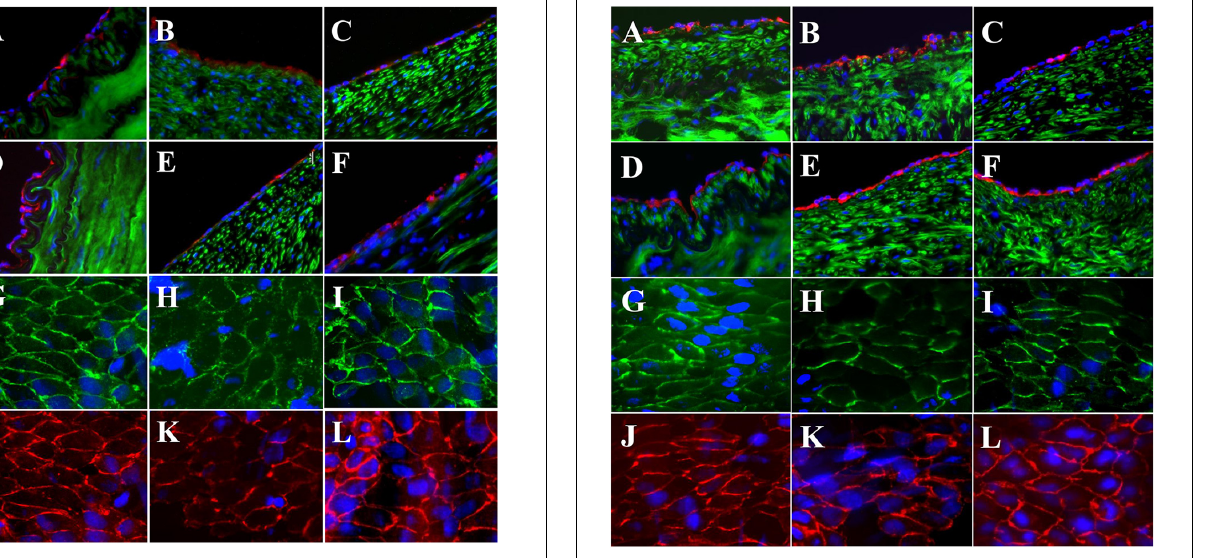
FIGURE 4 | Expression of endothelial biomarkers in neo-endothelial cells of femoral patch-angioplasty in 2-M and 4-M Groups. (A–F) Transverse. (A) Factor VIII in native artery. (B) Factor VIII in 2-M Group. (C) Factor VIII in 4-M Group. (D) eNOS in native artery. (E) eNOS in 2-M Group. (F) eNOS in 4-M Group. (G–L) En face. (G) VE cadherin in native artery. (H) VE cadherin in 2-M Group. (I) VE cadherin in 4-M Group. (J) PECAM-1 in native artery. (K) PECAM-1 in 2-M Group. (L) VE cadherin in 4-M Group. Red in (A–C) anti-Factor VIII. Red in (D–F) anti-eNOS. Green in (A–F) anti-SMC α -actin. Green in (G–I) anti-VE cadherin. Red in (J–L) anti-PECAM-1. Blue in all: nuclei of cells. Objective: 60 ×